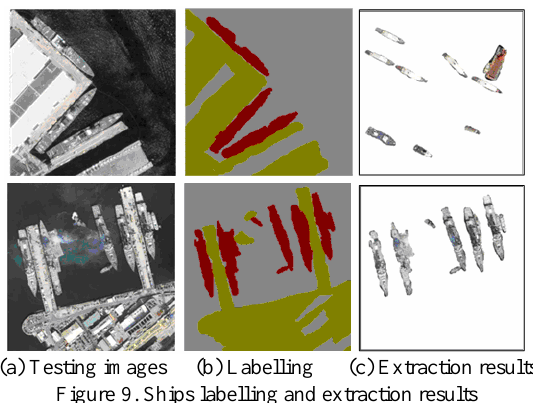
Figure 9. Ships labelling and extraction results